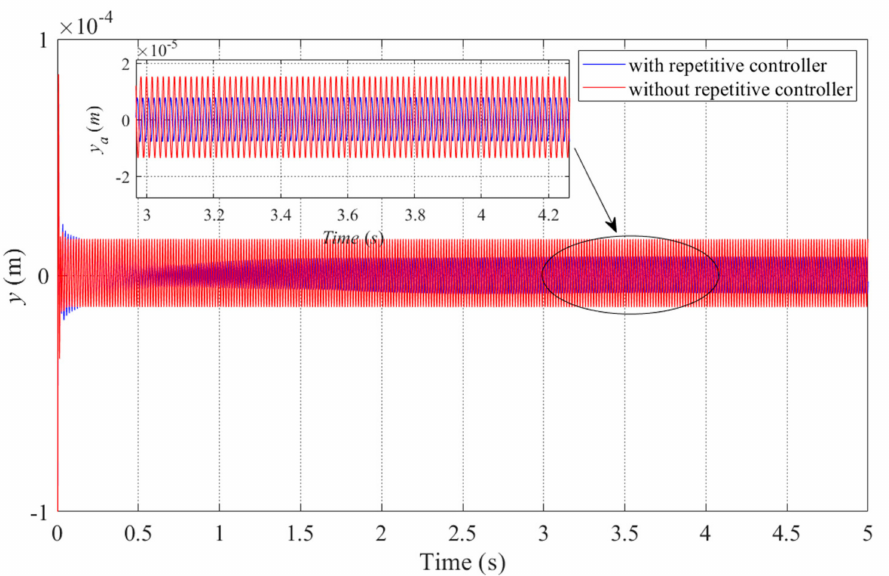
Figure 18. Trajectory of the rotor in the y -direction with repetitive control (blue curve) and without repetitive control (red